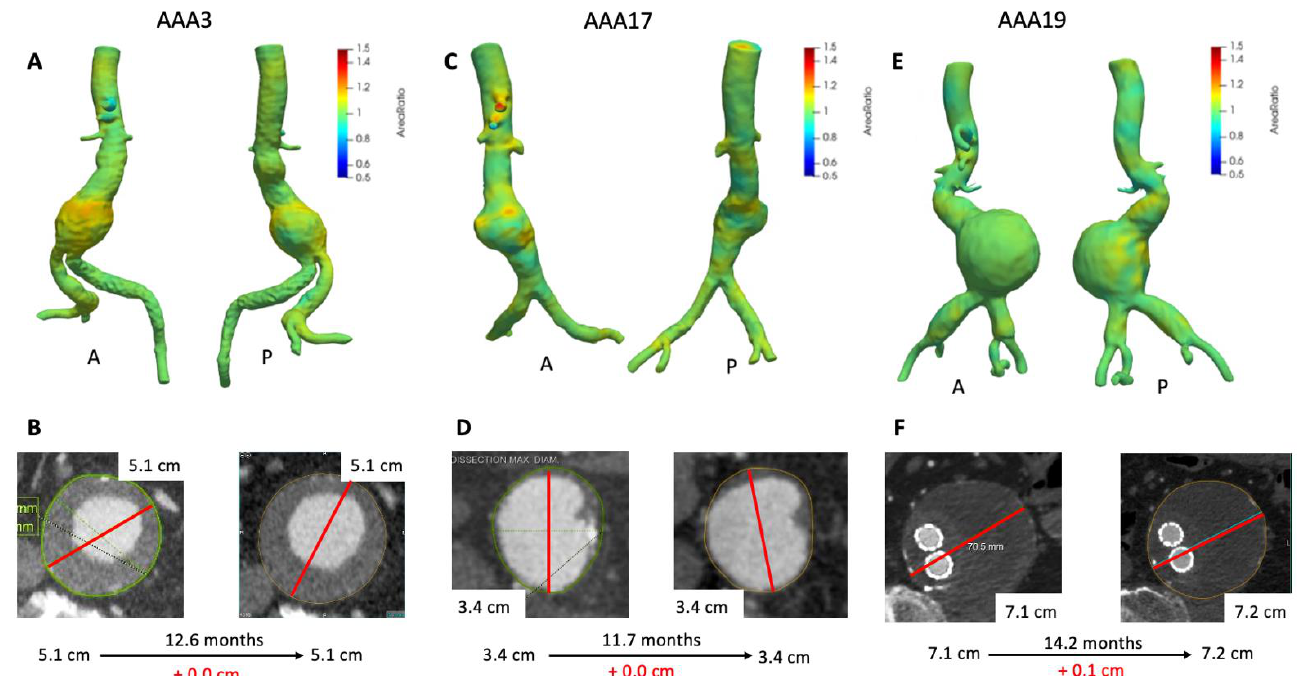
Figure 3. VDM analyses of AAA3, AAA17, and AAA19. VDM of AAA3 shows a moderate amount of growth anteriorly with some extending posteriorly ( A ), but maximum diameter was stable ( B ). VDM of AAA17 shows small punctate areas of growth anteriorly ( C ) but no growth by diameter assessment ( D ). AAA19 demonstrated no significant growth anteriorly, but there are two areas of subtle growth posteriorly ( E ), with maximum diameter change of +0.1 cm over 14 months ( F ). A = anterior projection, P = posterior projection.